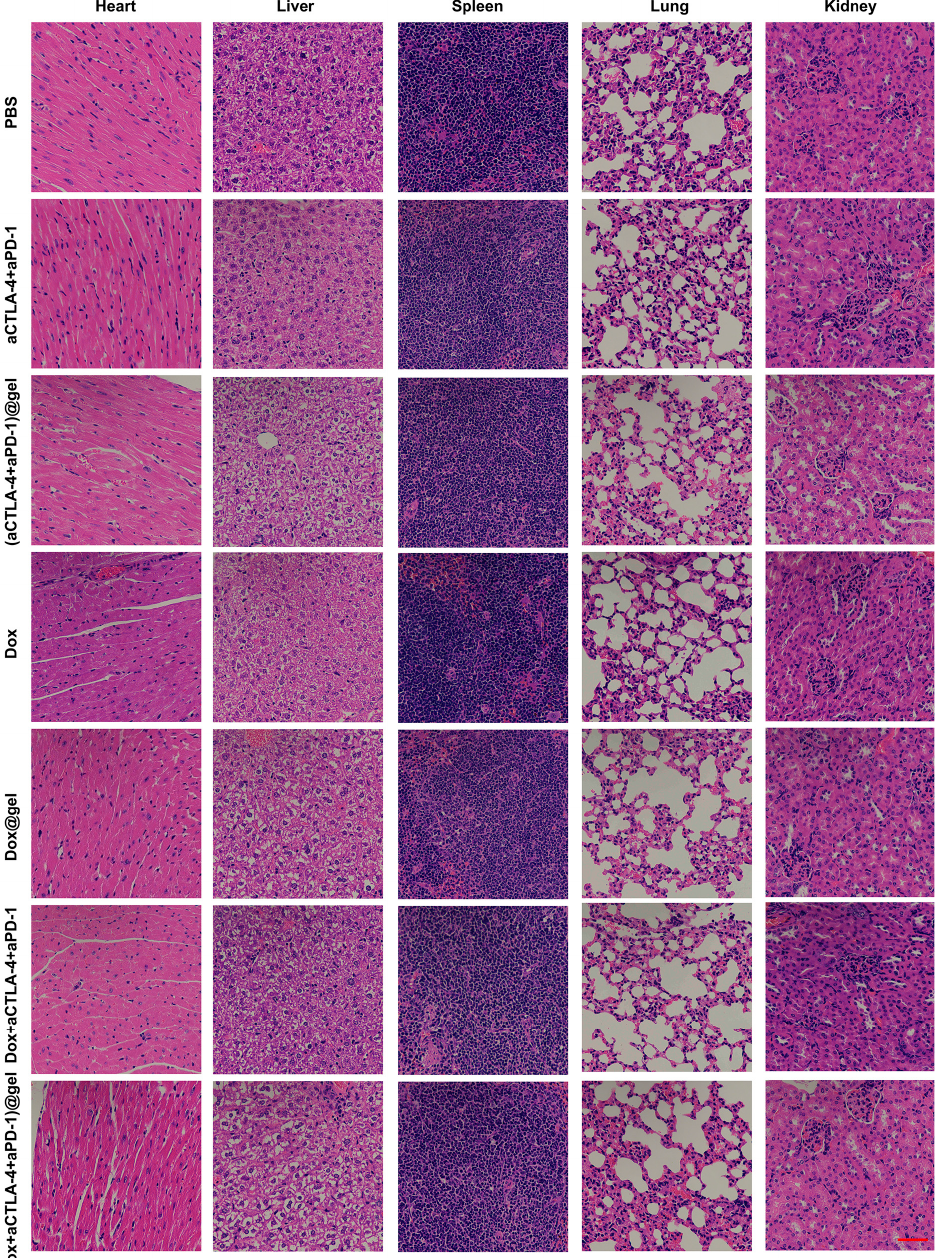
Figure 4. H&E staining images of the main organs of mice, including the heart, liver, spleen, lung and kidney, after 14 days of treatment with various therapeutic methods. Scale bar = 50 μ m.